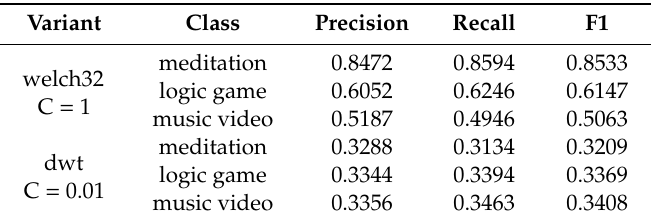
Table 14. Values of precision, recall, and F1 score for 10-fold cross-validation for the best and worst results resulted from the training / validation / test scheme as contained in Table 13. Variant Class Precision Recall F1 welch32 C = 1